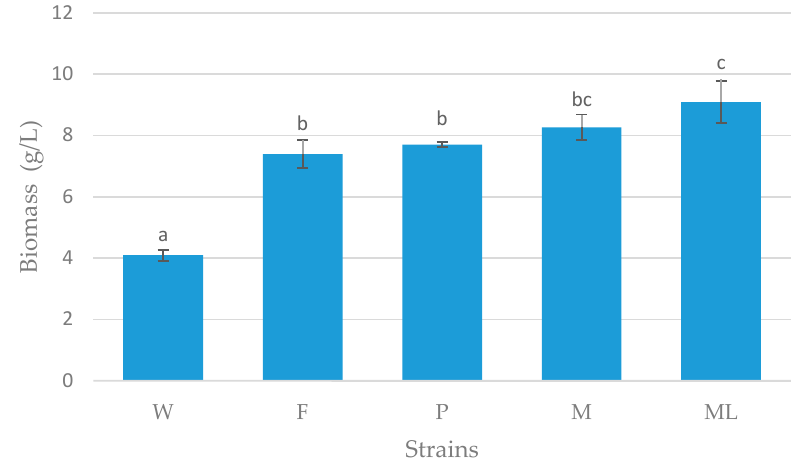
Figure 1. Study of 6-day shake flask cultures for biomass production by the W, F, P, M and ML strains/treatment. Glycerol based media under nitrogen-limiting conditions (C/N = 50). Error bars represent standard deviation for n = 3. W: H222 wild type strain, F: ∆ POX1 -6 ∆ LEU2 ∆ SNF1 ∆ FAA1 ∆ SNF1::URA3 , P: F + ∆ LEU2:: URA3 YlALK5 YlCPR YlFAO1 , M: P + YlALK5:: URA3 , ML: M + 400 mg/L leucine. abc Columns with dissimilar letters at the top are significantly different ( p < 0.05).